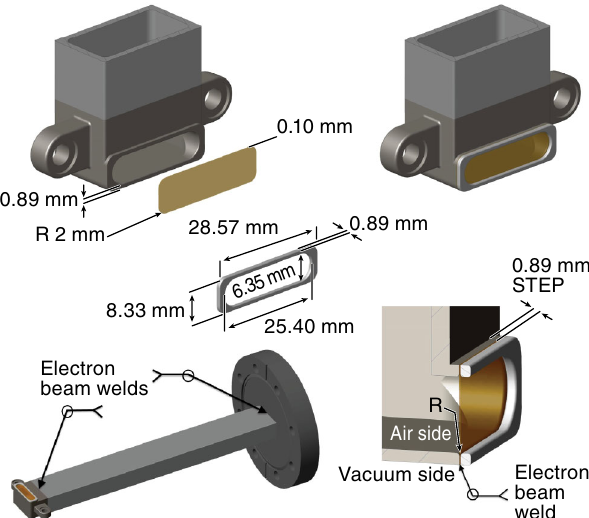
FIG. 8. Design and fabrication details of the cavity and the 0.1 mm thick titanium alloy window. The light guide is inserted in the cavity with the plastic scintillator facing the thin window. The electrons traverse this window from the vacuum outside of the cavity to the inside that is at atmospheric pressure.